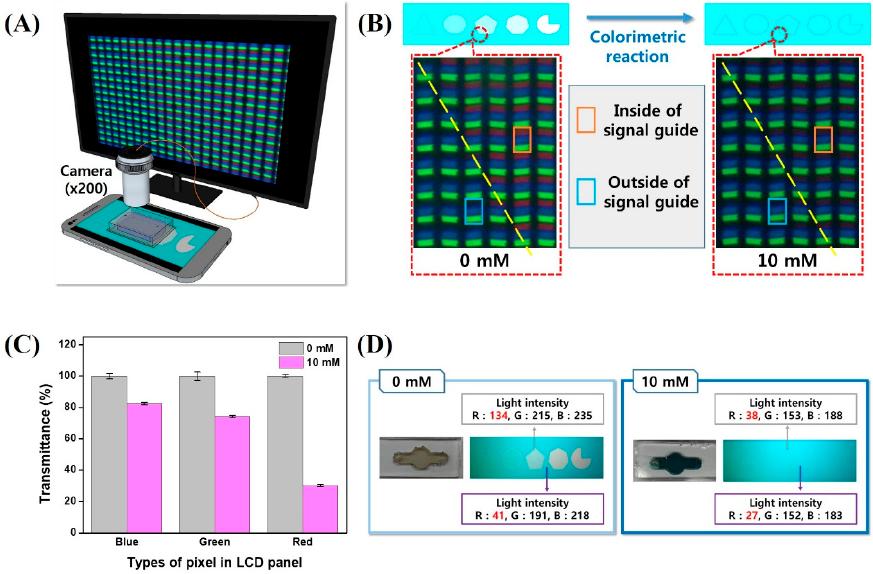
Figure 4. Alterations of RGB intensity on the mobile screen depending on the analysis of 0 or 10 mM glucose in the glucose assay: ( A ) The confirmation of changes in RGB pixels on the screen by microscopy. ( B ) The resulting images of the RGB pattern in the signal guide. The red light in the signal guide was changed by superimposing the blue chromogen-containing biosensing channel. ( C ) The transmittance ratio of blue, green, and red light in the signal guides. The blue and green lights slightly changed, while the red light is significantly altered. ( D ) The resulting images of a whole signal guide. The numbers of signal guides changed in the presence of a chromogen, and the red light highly decreased in the glucose assay involving a 10 mM glucose